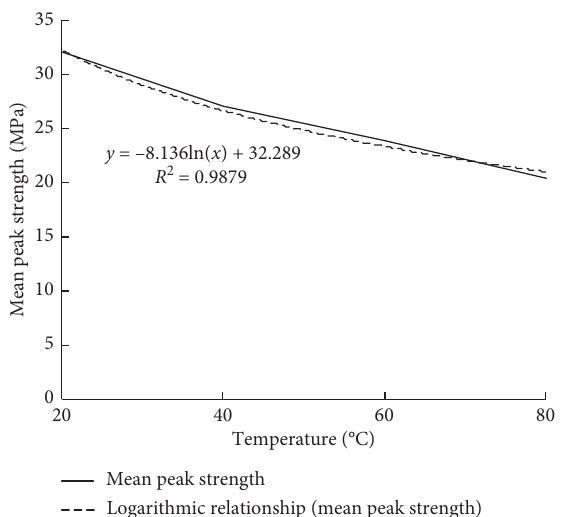
y = –8.136ln( x ) + 32.289 R 2 = 0.9879